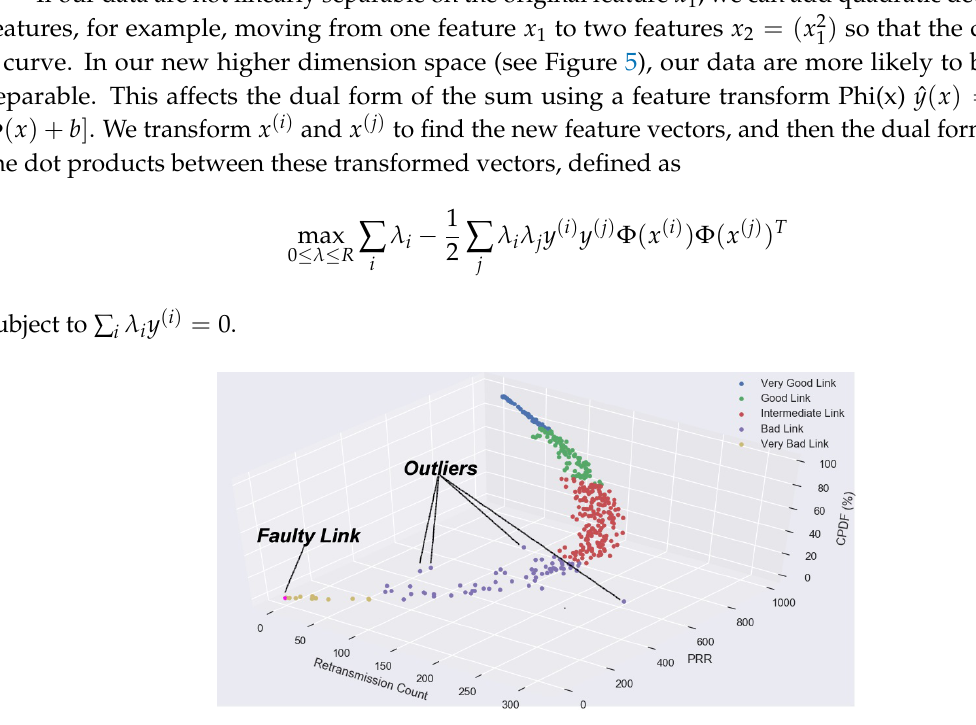
Figure 5. KLSVM: A modeled correlation-based high dimensional multi-category